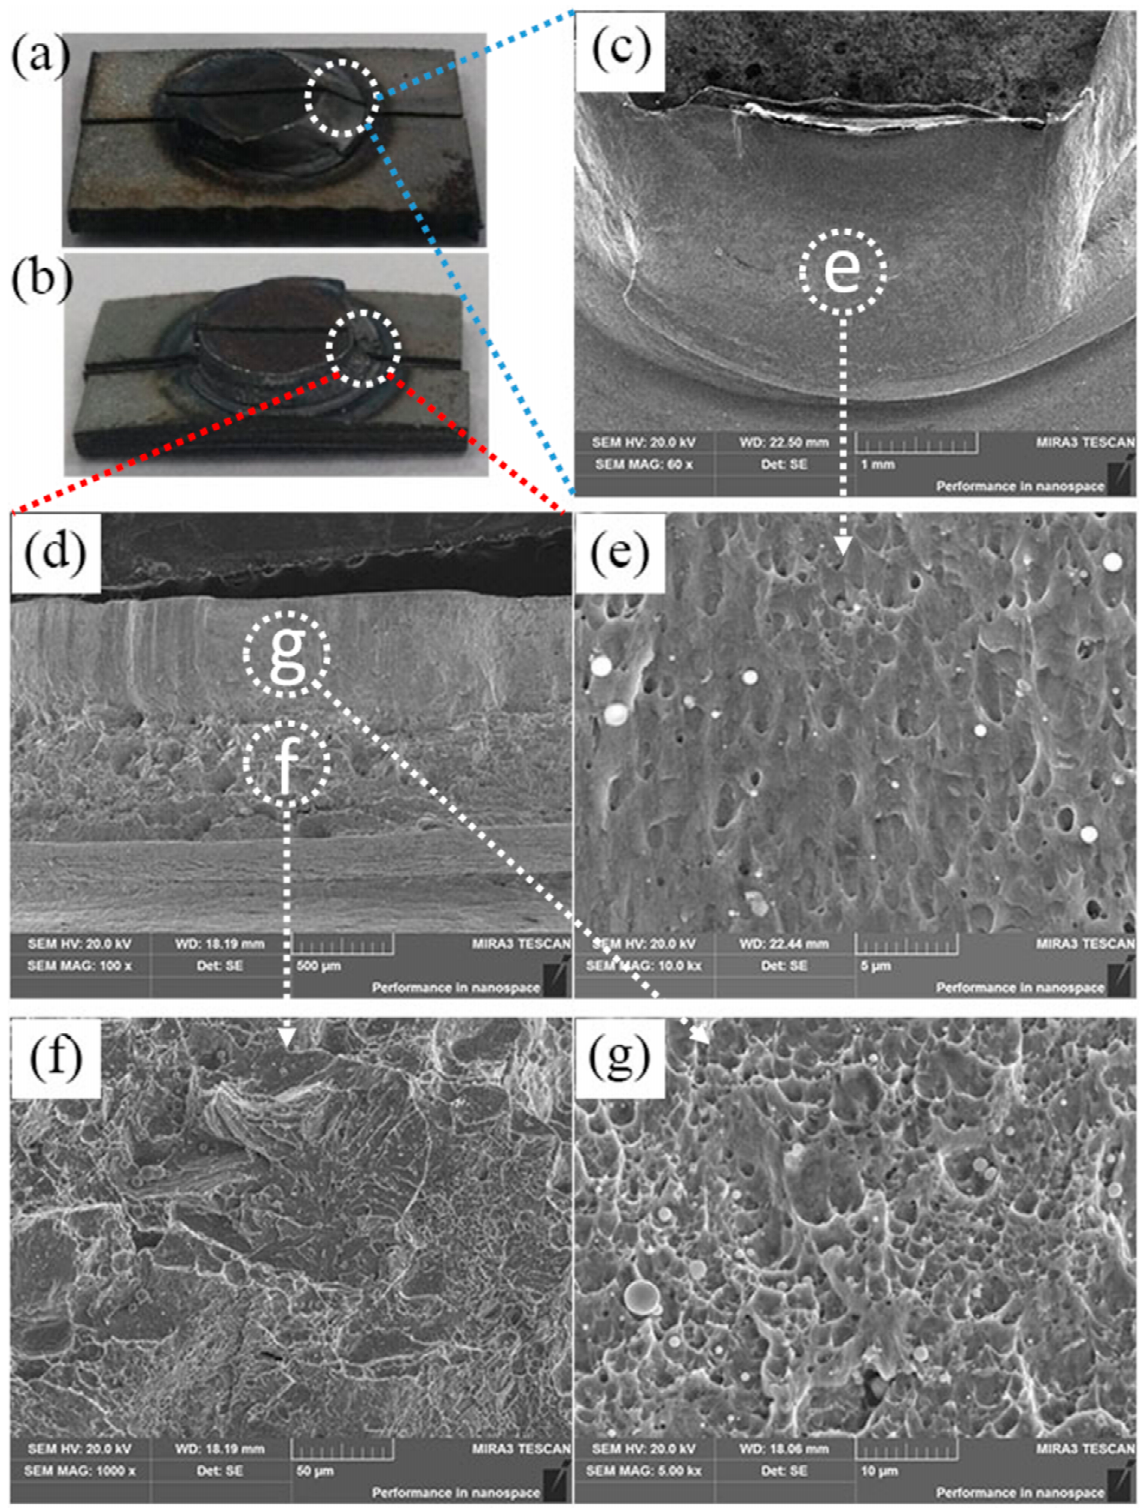
Figure 9. Typical fracture: ( a ) tension-shear and ( b ) cross-tension test, SEM images shows the fractographs of the fractured surface: ( c ) tension-shear and ( d ) cross-tension and the magnified images of the selected zone with marked by ( e – g ).